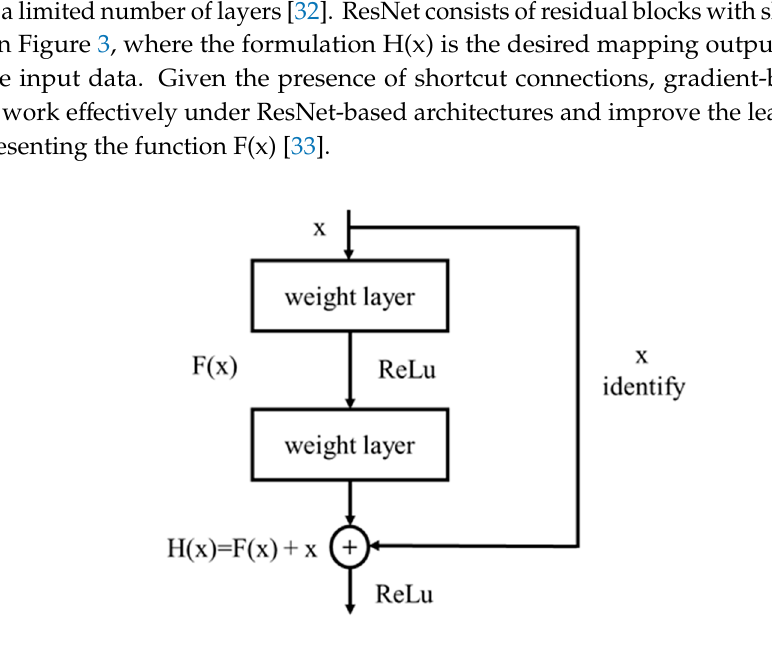
Figure 2. Deep neural network (DNN) with two hidden layers [20].